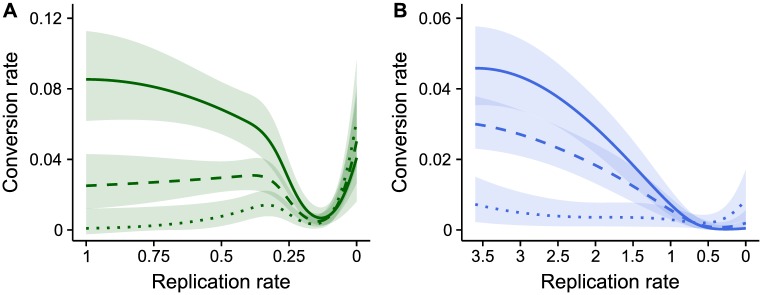
In addition to state, changes in red blood cell (RBC) density modulate conversion rates.The reproductive restraint region of reaction norms for (A) ER and (B) CWvir are steeper when RBC density is increasing (solid lines; 90th percentile) compared to remaining constant (dashed lines; 50th percentile) or decreasing (dotted lines; 10th percentile). Percentiles for RBC change are used to normalise for the differing dynamics between the experiments and are calculated as the difference in RBC density between the decision-making and parental cohorts of asexuals. Solid lines and shaded areas are predictions ± SEM from generalised additive models for conversion as a function of both replication rate (state) and changes in RBC density.